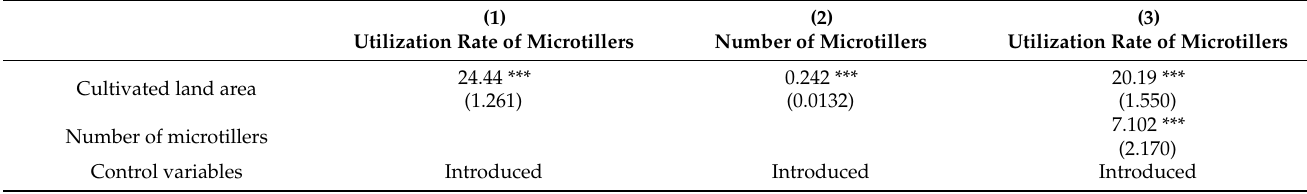
Table 4. Results for mediating effect test with stepwise method.